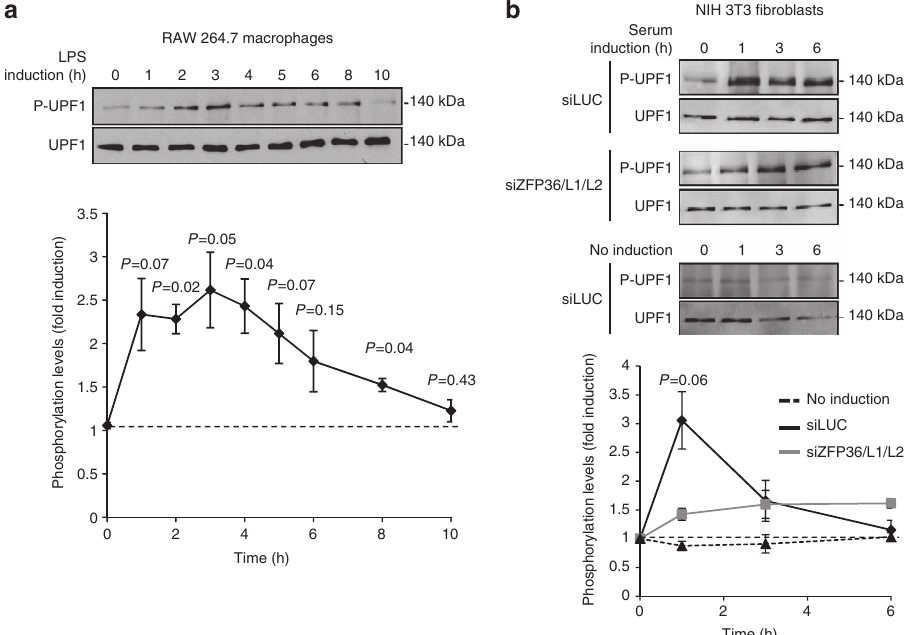
Figure 3 | Transient increase in UPF1 phosphorylation upon activation of ARE-mediated decay. ( a ) Western blots showing endogenous UPF1 phosphorylation levels in RAW 264.7 cells treated with LPS and monitored as in Fig. 1a. Numbers refer to hours after LPS addition. Graph showing UPF1 phosphorylation levels quantified as in Fig. 1 is shown below. Indicated values are normalized to the zero time point ± s.e.m. from three independent experiments. P values are relative to time zero and were calculated using paired two-tailed Student’s t -test. ( b ) Western blots showing UPF1 phosphorylation levels in NIH 3T3 cells transfected with siRNAs targeting either Firefly Luciferase (LUC) or ZFP36, ZFP36L1 and ZFP36L2 (ZFP36/L1/L2). Numbers above panels refer to time after serum induction; lower panel shows uninduced cells. Graph showing UPF1 phosphorylation levels measured from three independent experiments as in a is shown below. P value is comparing siLUC to siZFP36/L1/L2 conditions at 1h after serum induction using the paired two-tailed Student’s t